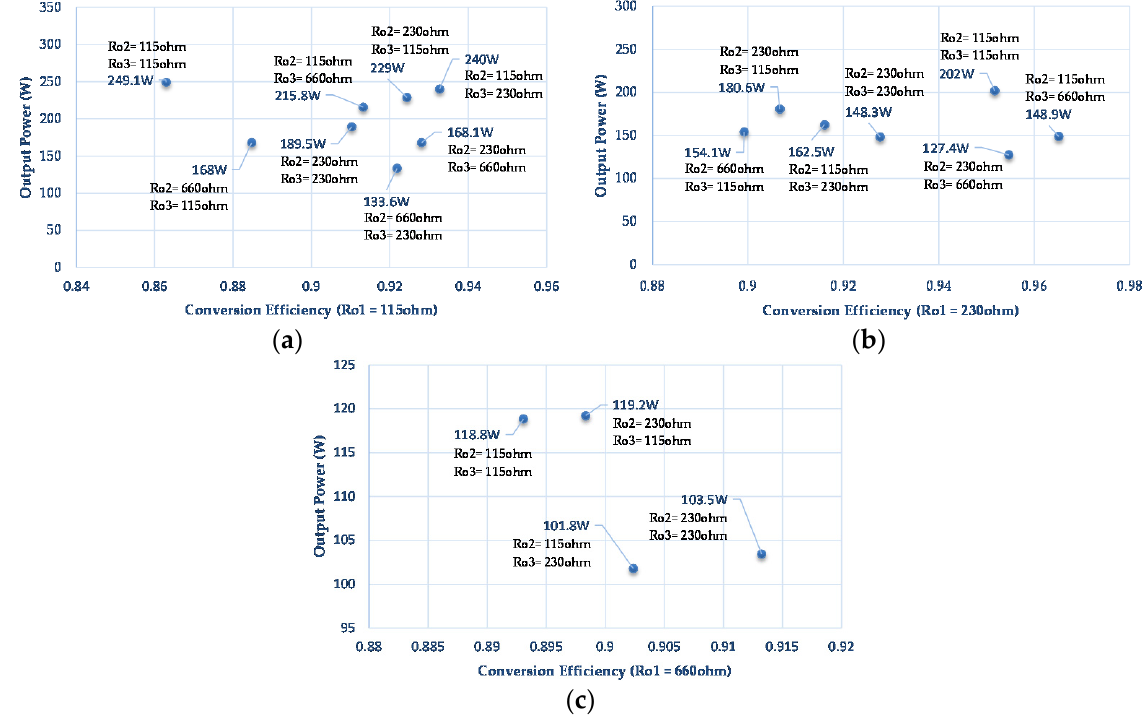
Figure 16. Measured conversion efficiency under different load conditions in the battery discharging mode: ( a ) R o1 = 115 Ω ; ( b ) R o1 = 230 Ω ; and ( c ) R o1 = 660 Ω conditions.